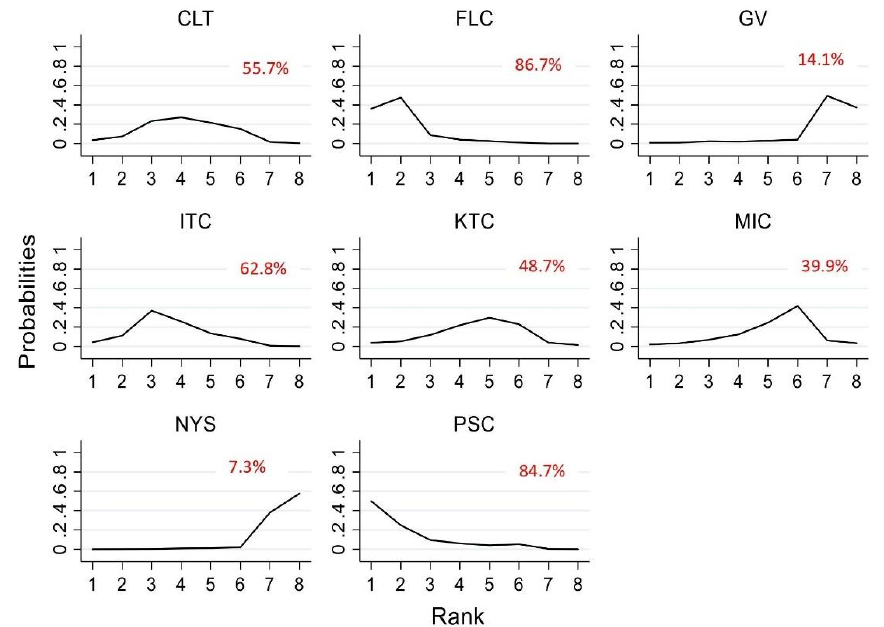
Figure 3. Network plot comparing the efficacy of antifungal agents used for the treatment of OPC among HIV-infected adults (clinical cure). Abbreviations: CLT — clotrimazole, FLC — fluconazole,